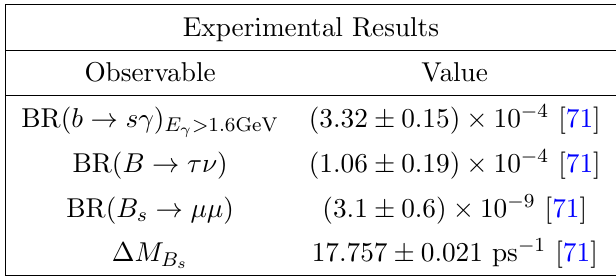
Table 4 . Experimental results for (cid:13)avor